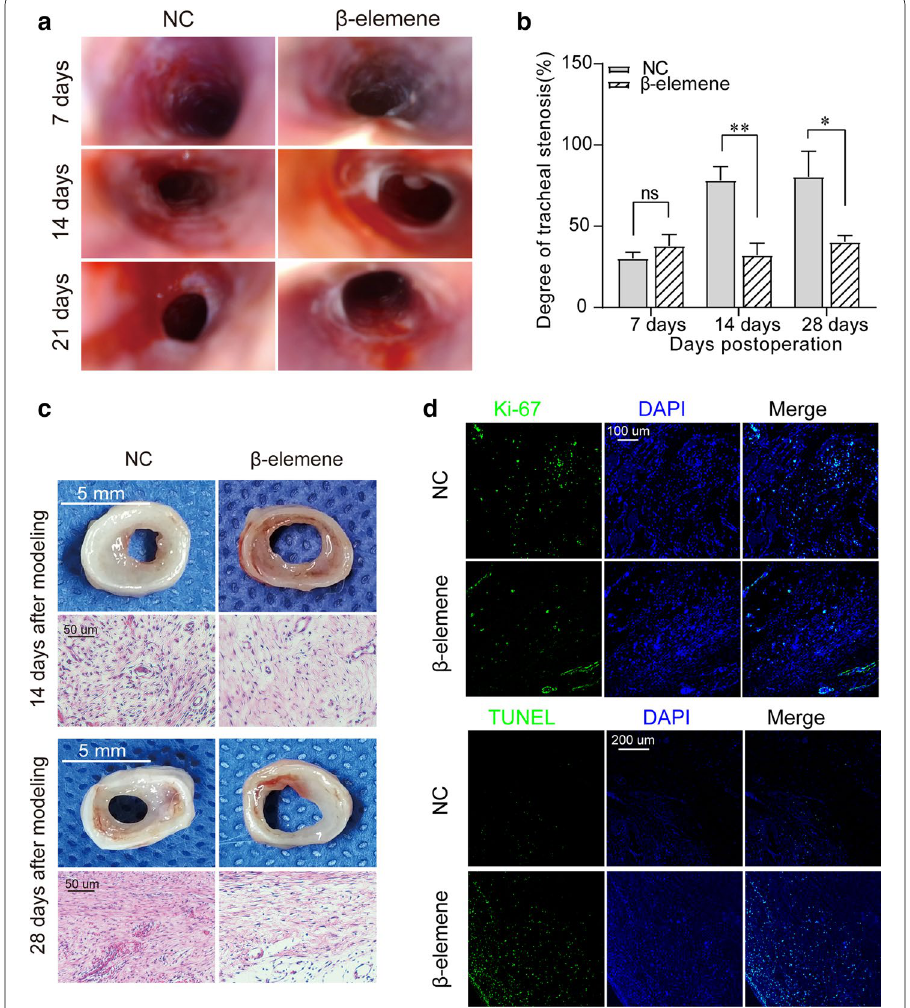
Fig. 8 β-Elemene prevented tracheal stenosis in a rabbit model of tracheal stenosis. a , b Endoscopic examination and measurement of tracheal stenosis in rabbit models treated with β-elemene; * P < 0.05; ** P < 0.01; # P < 0.05; ## P < 0.01; ns, not significant. c Gross examination and H&E staining of the stenotic trachea. d Immunofluorescent staining of Ki67. e Representative images of TUNEL